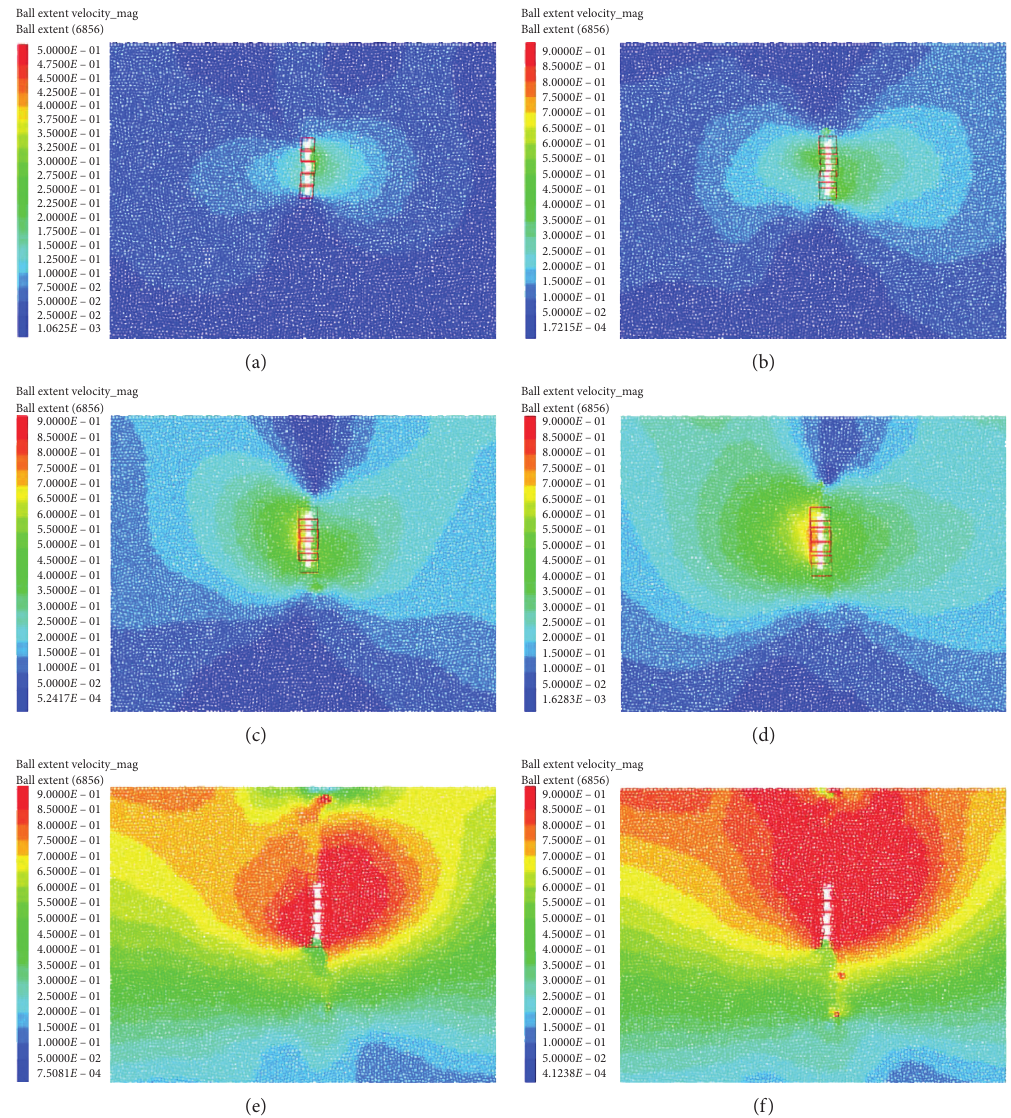
Figure 7: Propagation process of explosion stress wave of cylindrical charge: (a) 1.0ms, (b) 1.5ms, (c) 2.0ms, (d) 2.5ms, (e) 3.0ms, and (f)